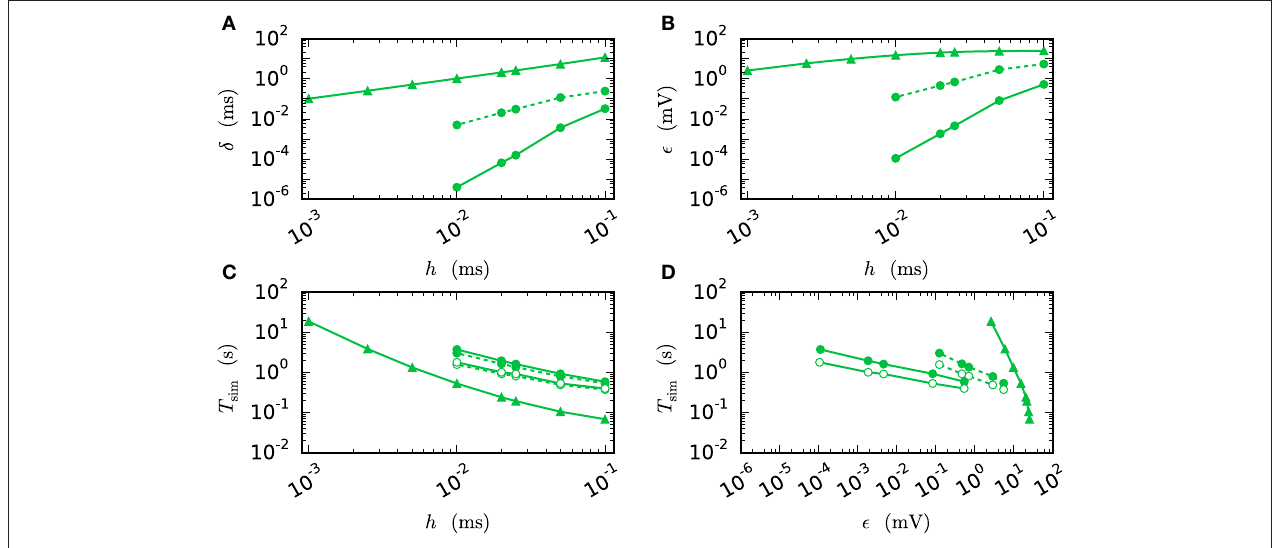
FIGURE 7 | Efficiency of a two-neuron simulation. Triangles show results with the single-step method, while circles indicate results obtained by the iterative method. Again solid curves indicate cubic interpolation and dashed curves were obtained with linear interpolation. The used communication scheme is indicated by open ( h -step communication) and filled symbols (communication in intervals of the minimal delay). The iteration control was used with prelim_tol chosen as 10 − 6 . (A) Shift of the spike times after 1 s of biological time plotted against used step size h . (B) RMSE ǫ measured over 1 s of biological time plotted against the step size h . (C) Simulation time of the different approaches for 1 s of biological time. (D) Simulation time vs. RMSE ǫ of the corresponding